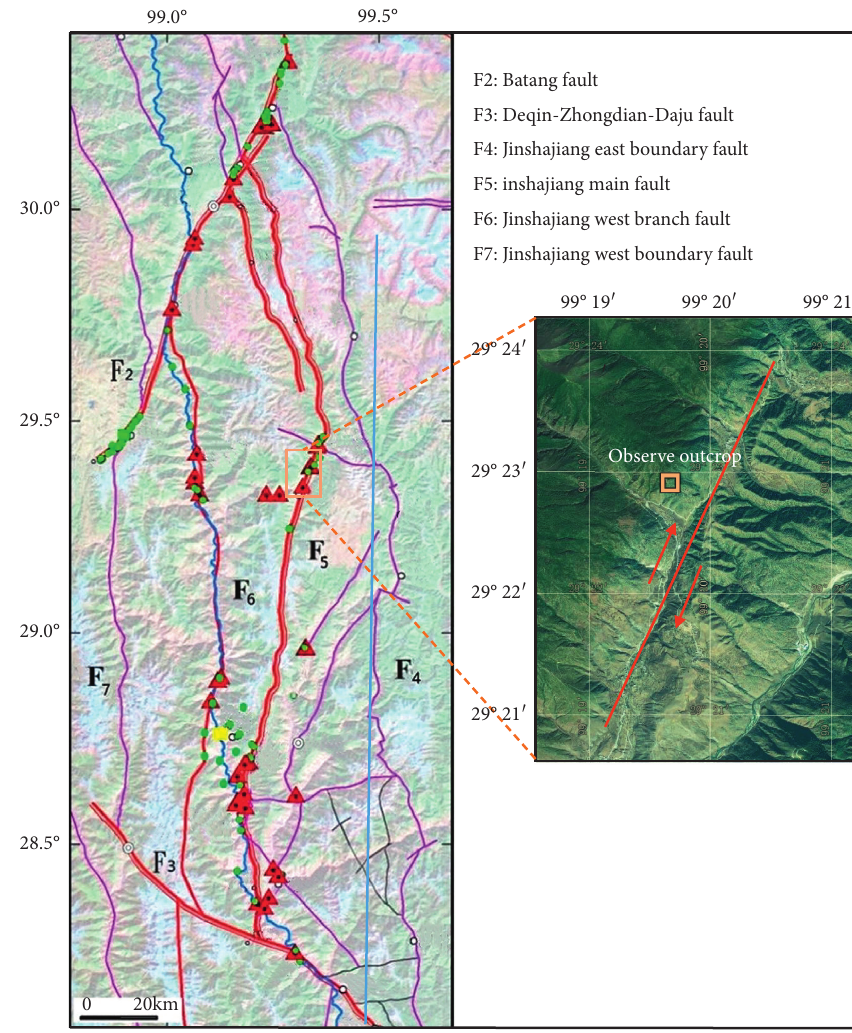
Figure 2: Jinshajiang fault zone [14] and observed outcrop